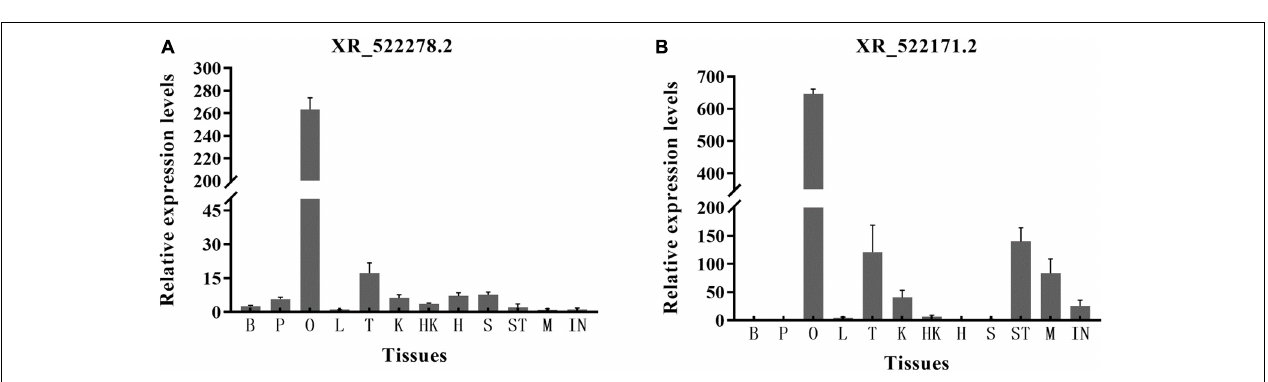
FIGURE 7 | The expression level of lncRNAs XR_522278.2 (A) and XR_522171.2 (B) in 12 tissues. B, brain; P, pituitary; O, ovary; L, liver; T, testis; K, kidney; HK, head kidney; H, heart; S, spleen; ST, stomach; M, muscle; IN, intestines.